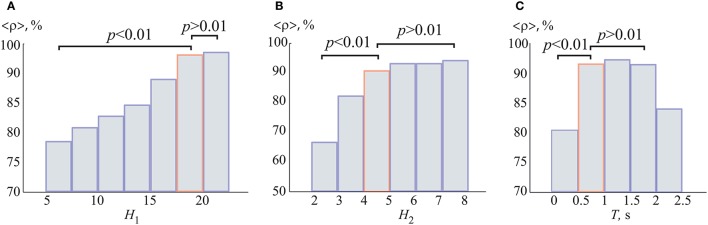
Recognition accuracy as a function of the number of neurons (A)
H1 in the first hidden layer (for H2 = 5) and (B)
H2 in the second hidden layer (for H1 = 19). We used single EEG trials with T = 1 s duration (250 samples). (C) Recognition accuracy as a function of duration T of single EEG trials. The accuracies were averaged over all 1,000 training ANNs. All data was averaged all participants in the group. p-values were calculated via paired t-test. The boxes highlighted in orange correspond to the optimal parameters.